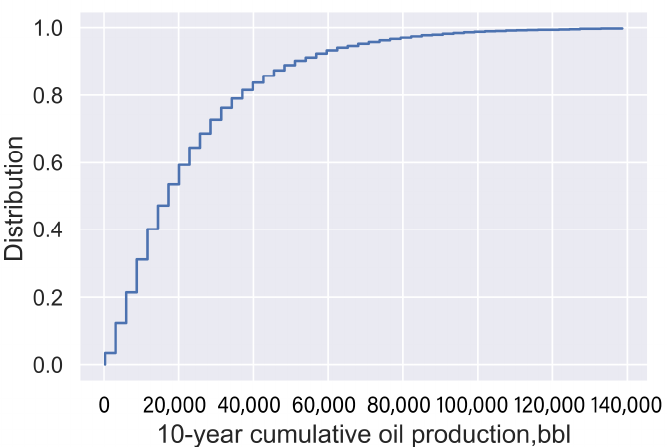
Figure 9. Cumulative probability distribution of 10-year cumulative oil production obtained by the numerical simulation.